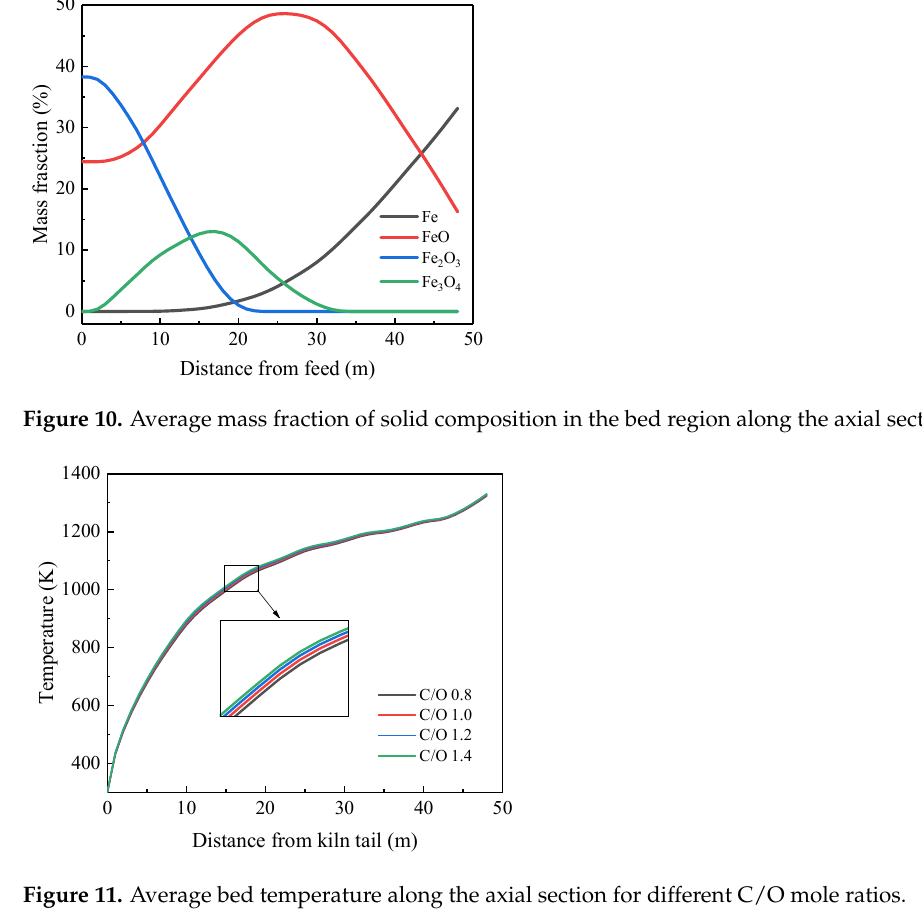
Figure 11. Average bed temperature along the axial section for different C/O mole ratios.